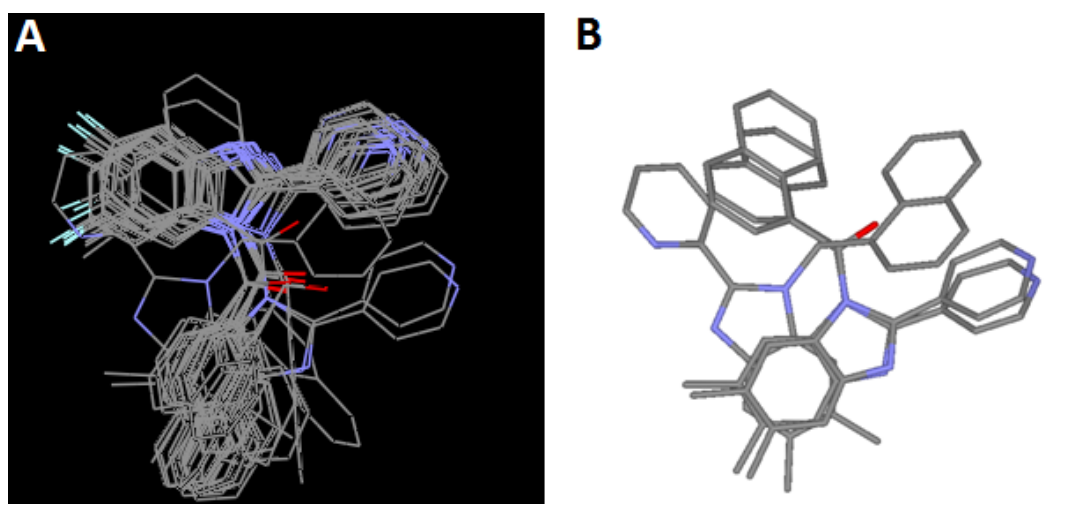
Figure 6. ( A ) Alignment of the 29 studied molecules. ( B ) Docking conformation of compounds 21 , 36 and 44